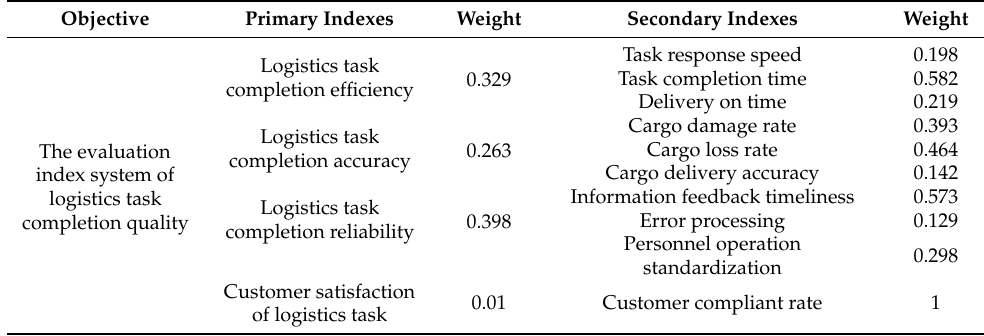
Table 7. The weight of logistics task completion quality evaluation